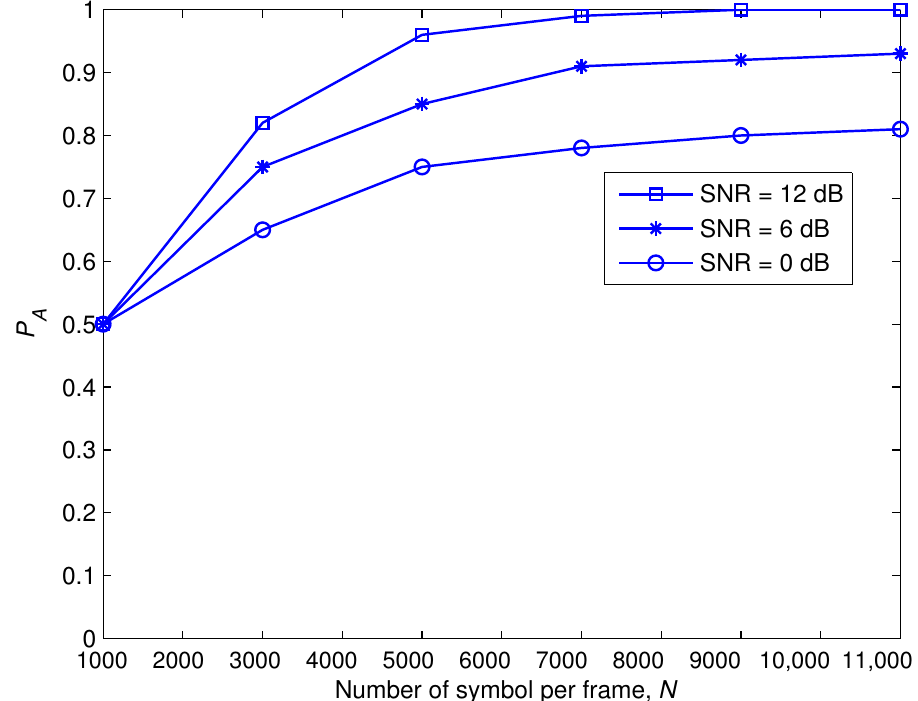
Figure 17. The effect of N on the categorization performance for the modulation set of Ω 2